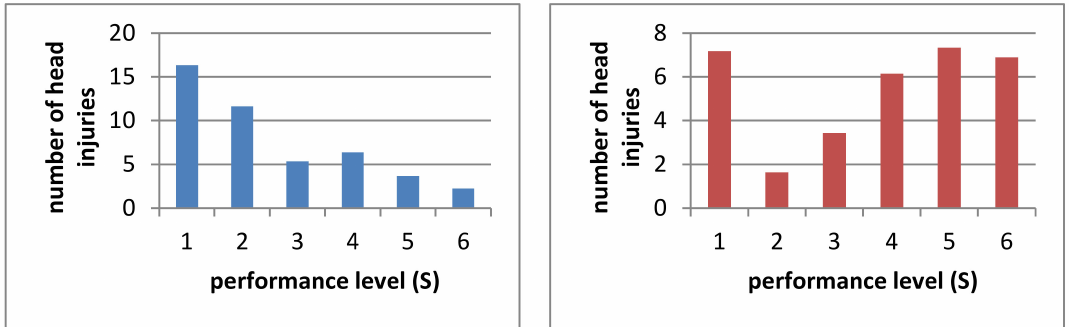
Figure 2. Number of head injuries by performance level ever (blue) and in 1000 h